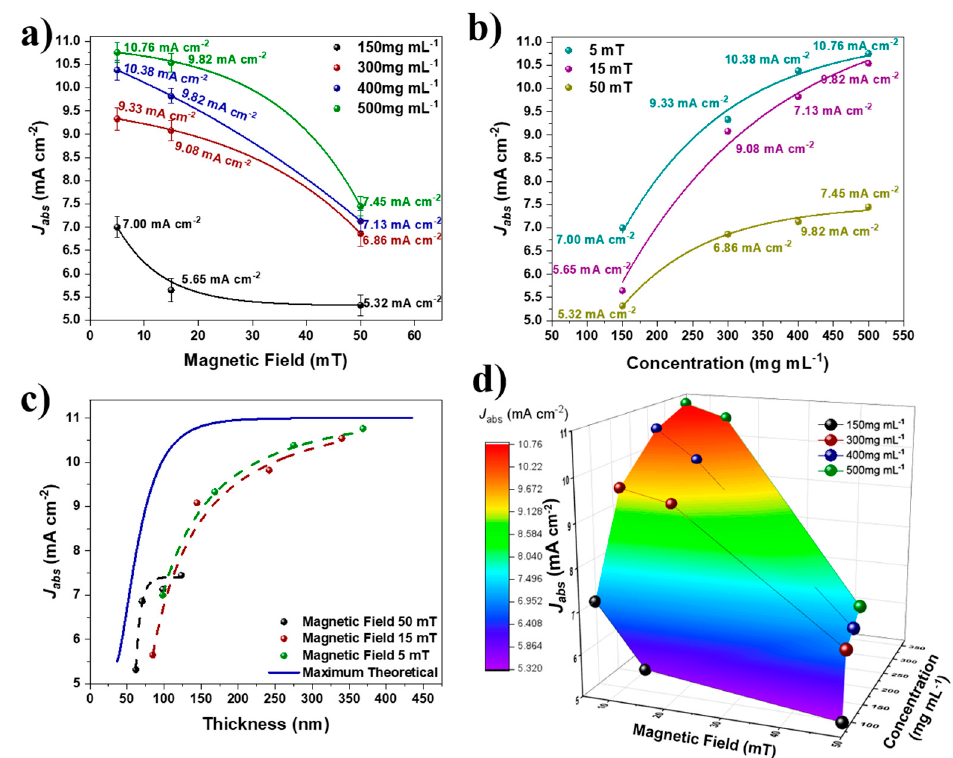
Figure 7. Relationship of film J abs with: ( a ) magnetic field; ( b ) nanoparticle concentration; ( c ) thickness of hematite films; and ( d ) graph of response surface showing the relationship of magnetic field, thickness, and J abs .